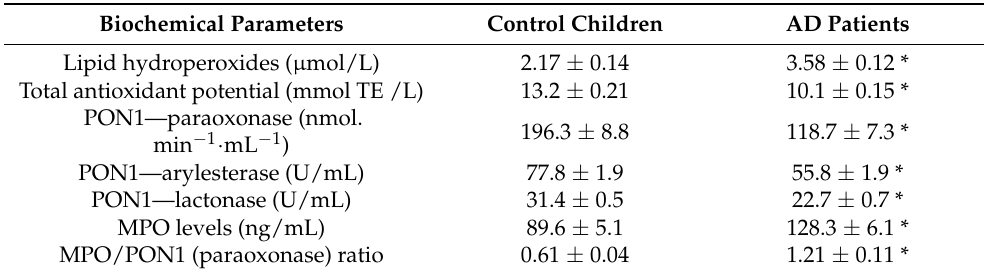
Table 2. Serum PON1 activities (paraoxonase, arylesterase, lactonase), lipid hyperoxides, and myeloperoxidase (MPO) levels in controls and AD children; p < 0.05 vs. control children. Results reported as mean ± standard error (SE). * p < 0.001 vs. control children.